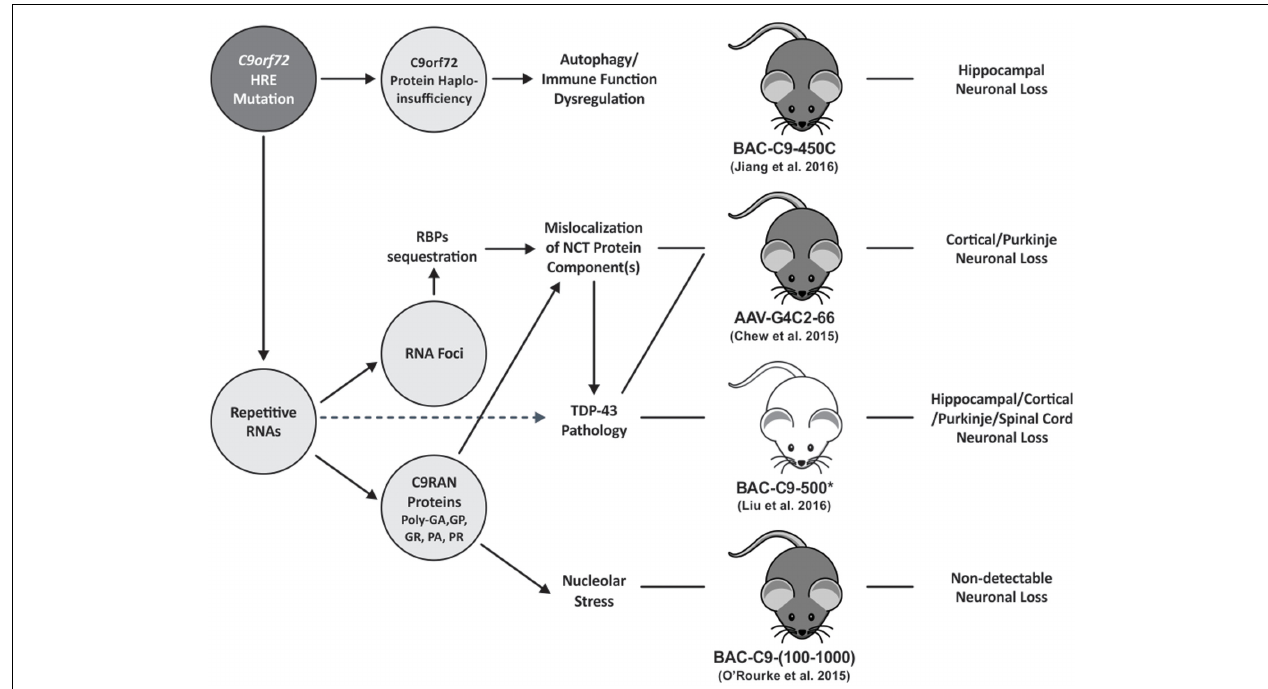
FIGURE 1 | The schematic diagram summarizes the pathomechanisms of C9orf72 HRE FTD/ALS. HRE containing RNAs are transcribed in C9FTD/ALS tissues. The repetitive RNA forms nuclear RNA foci or is exported to the cytoplasm where it undergoes RAN translation into poly-dipeptide-repeat C9RAN proteins. Like other microsatellite repeat expansion disorders, RNA foci induced by C9orf72 HRE can sequester RBPs leading to their loss-of-function. G4C2-repeat RNA foci may alter the distribution and/or impair NCT function as shown in a mouse model (Zhang et al., 2016) and drosophila models (Freibaum et al., 2015; Zhang et al., 2015). Mislocalization of NCT components may also be caused by certain species of C9RAN proteins as shown in overexpression cell or animal models (Jovicic et al., 2015; Khosravi et al., 2017; Zhang et al., 2016). Notably, reduced nuclear-to-cytoplasm ratio of TDP-43 protein, a shuttling RBP, was detected in a of 30 G4C2 repeat overexpression drosophila model (Zhang et al., 2015) suggesting that TDP-43 pathology may be the result of impaired NCT function. However, additional mechanisms that link repetitive RNA expression with TDP-43 pathology are likely present. Elucidation of these molecular pathways is important as TDP-43 pathology burden is highly correlated with the severity of neurodegeneration (Neumann et al., 2006; Mackenzie et al., 2015). Furthermore, Arginine-rich C9RAN proteins [i.e., poly(GR), poly(PR)], were shown to induce nucleolar stress in cell and in drosophila models (Kwon et al., 2014; Wen et al., 2014; Lee et al., 2016). C9orf72 HREs may cause loss of C9orf72 gene-expression leading to haploinsufficiency. Multiple C9orf72 knockout mouse models have consistently demonstrated the essential role of C9orf72 protein in autophagy and immune function regulation (Atanasio et al., 2016; Jiang et al., 2016; O’Rourke et al., 2016; Ugolino et al., 2016; Ji et al., 2017). But it is unclear how reduced C9orf72 protein function may contribute to C9orf72 HRE FTD/ALS mechanism. Solid line arrows illustrate links supported by mechanistic data; whereas dotted line arrows illustrate links supported by correlation data. Pathological features reported in different C9orf72 HRE mouse models are also illustrated. However, the pathomechanisms leading to neuronal loss in these models are still not clear. Mouse body color was selected based on strain information. Asterisk represents all acute-progress C9 mice in Liu et al. (2016) study. HRE, hexanucleotide repeat expansion; RBPs, RNA-binding proteins; NCT, nucleocytoplasmic